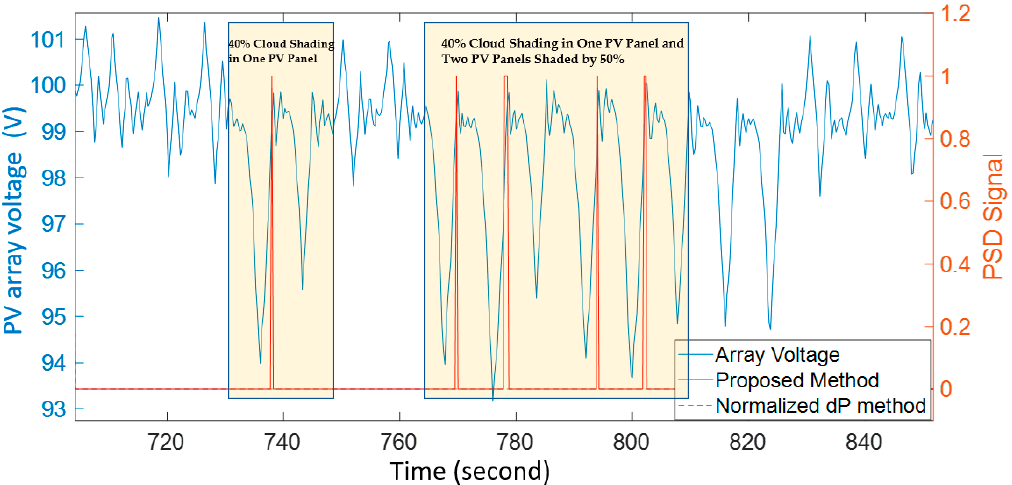
Figure 8. Series–parallel PV array voltage waveforms and PSD signals during the cloud shading simulation.